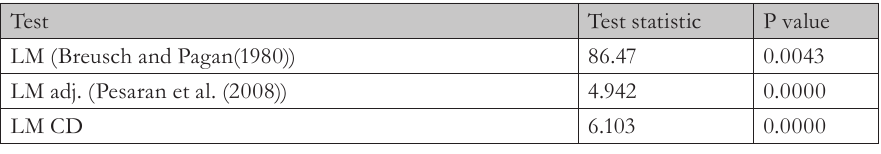
Tab. 3 – Results of cross-sectional dependency tests. Source: own